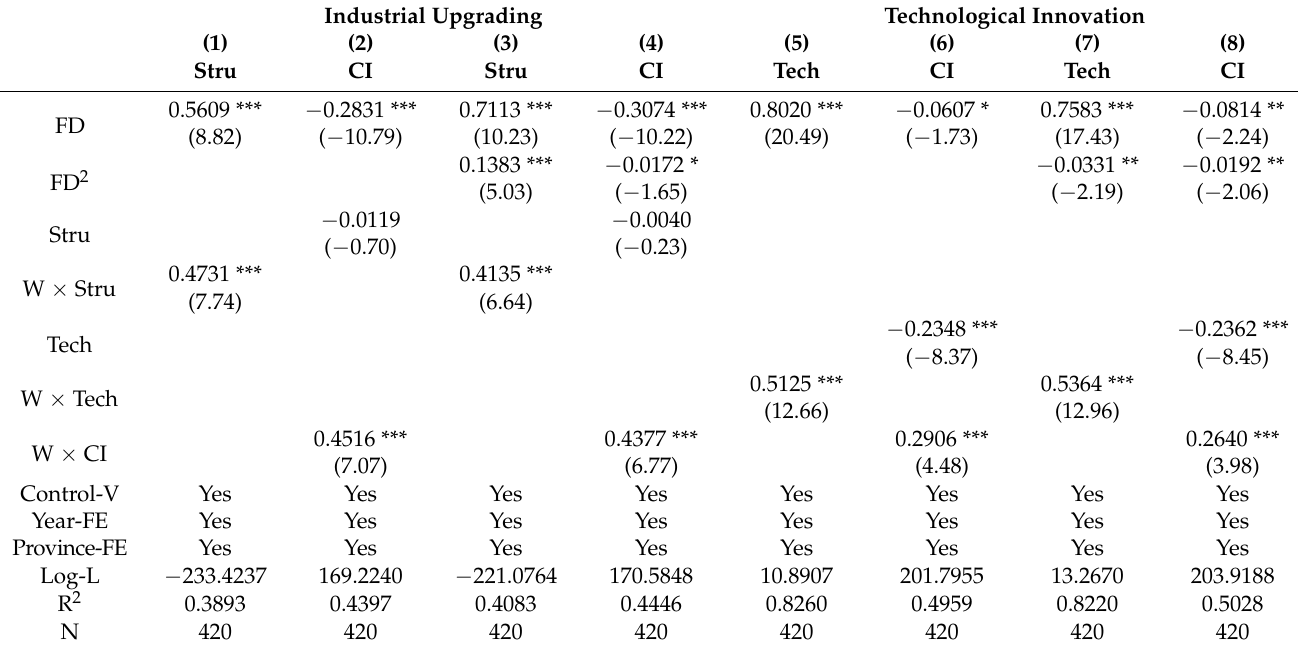
Table 7. Results of the mediating effect